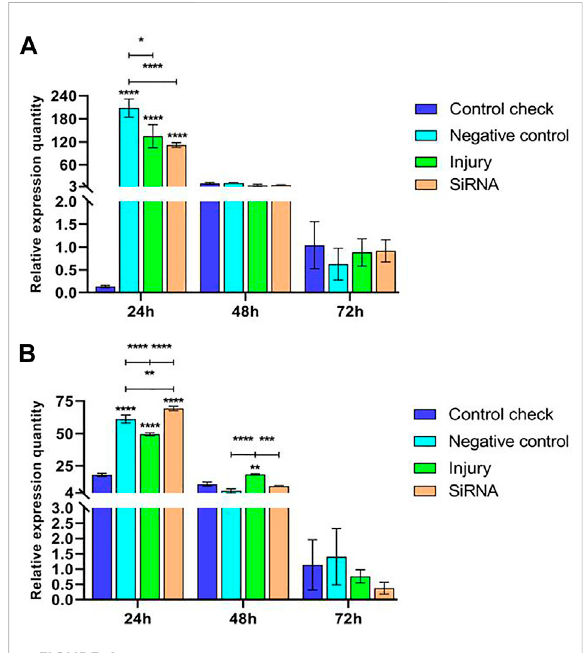
FIGURE 3 FIGURE 4 Effects of interfering target genes on the Vitellogenin Effects of interfering target genes on Vitellogenin-1 gene receptor gene expression in Z. cucurbitae (Coquillett). (A) expression in Z.cucurbitae (Coquillett). (A) Interfering target genes Interfering target genes after the 25 ° C treatment for 1 h ( F (3, 24) = afterthe25 ° Ctreatmentfor1 h( F (3,24) =19.43, p < 0.0001; F (2,24) = 119.9, p < 0.0001; F (2, 24) = 557.3, p < 0.0001; F (6, 24) = 75.67, 124.6, p < 0.0001; F (6, 24) = 19.61, p < 0.0001). (B) Interfering p < 0.0001). (B) Interfering target genes after the 45 ° C treatment target genes after the 45 ° C treatment for 1 h ( F (3, 24) = 84.23, p < for 1 h ( F (3, 24) = 49.97, p < 0.0001; F (2, 24) = 49.26, p < 0.0001 ; F (6, 0.0001; F (2, 24) = 1,436, p < 0.0001; F (6, 24) = 103.4, p < 0.0001). All fi gure are presented as values in the fi gure are presented as mean ± standard error. *, **, 24) = 4.778, p = 0.0025). All values in the mean ± standard error. *, **, ***, and **** above the histograms ***, and **** above the histograms indicate the values that differ indicate the values that differ signi fi cantly between treatments p ≤ signi fi cantly between treatments p ≤ 0.05, p ≤ 0.01, p ≤ 0.001, and 0.05, p ≤ 0.01, p ≤ 0.001, and p ≤ 0.0001, respectively. p ≤ 0.0001,